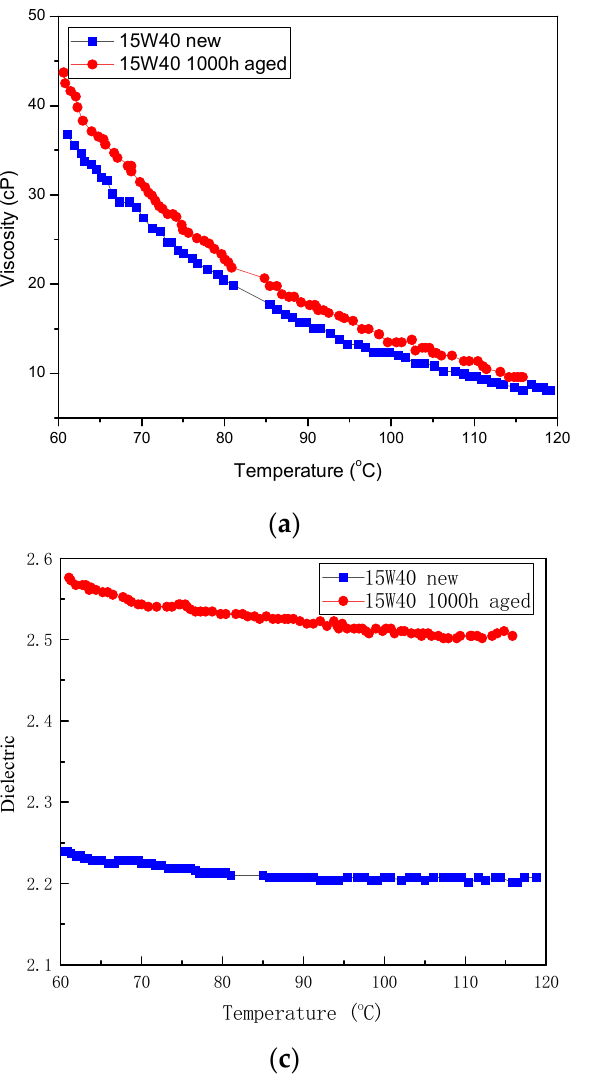
Figure 6. New and aged engine oil (15W40): ( a ) viscosity; ( b ) density; ( c ) dielectric; and ( d ) Rp.